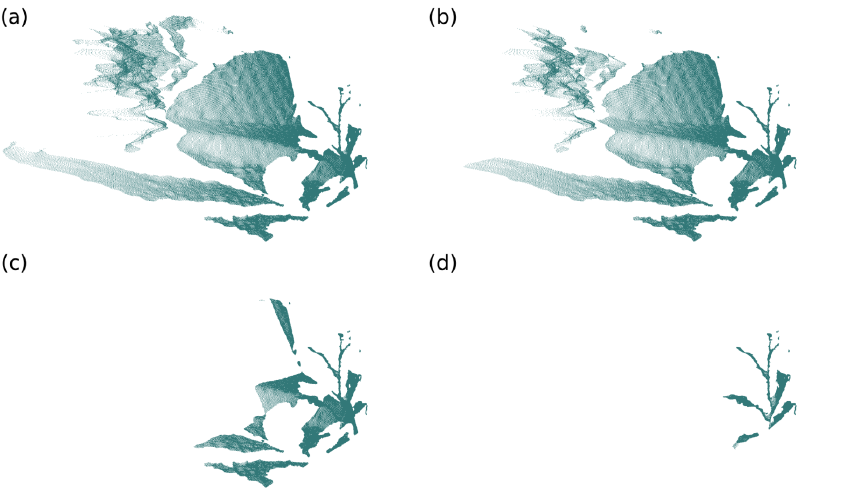
Figure 5. Example of background removal in a point cloud considering a cutoff factor of 0.2. ( a ) Input point cloud ( d min = 0.29m and d max = 22.9m); ( b ) linear cutting (at 4.81m); ( c ) cutting by the proposed technique with base 10 (at 1.76m); ( d ) cutting by the proposed technique with base 100 (at 0.63m).